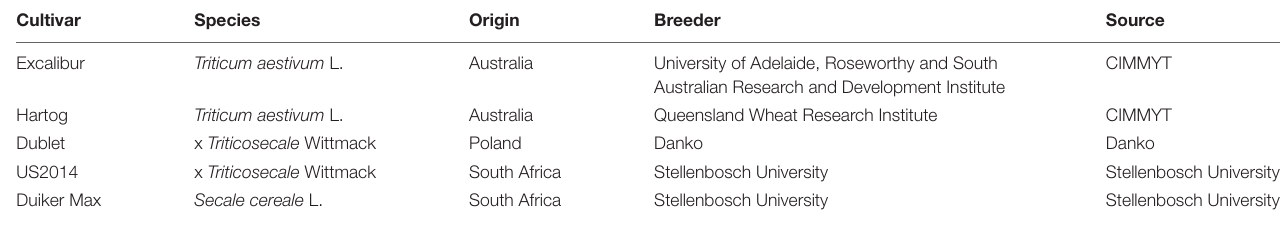
TABLE 1 | Different cultivars of wheat, triticale, and rye used in this study.